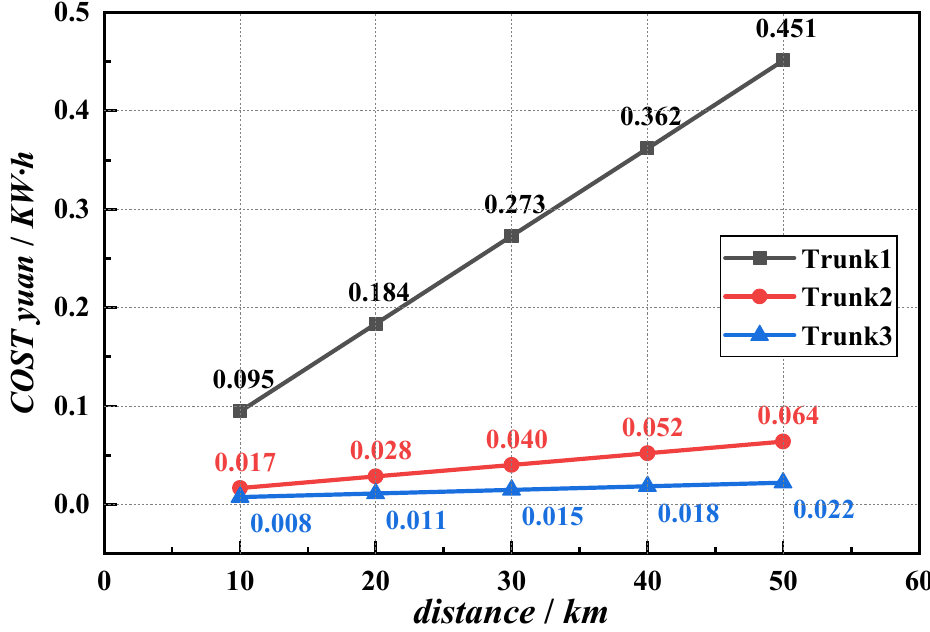
Figure 8. Cost varies with distance under different vehicle types.